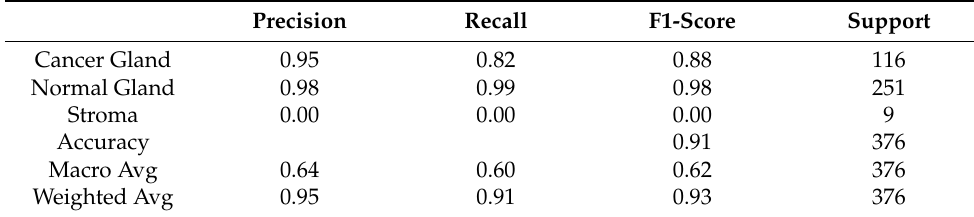
Table 2. The gland detection report on the test dataset.